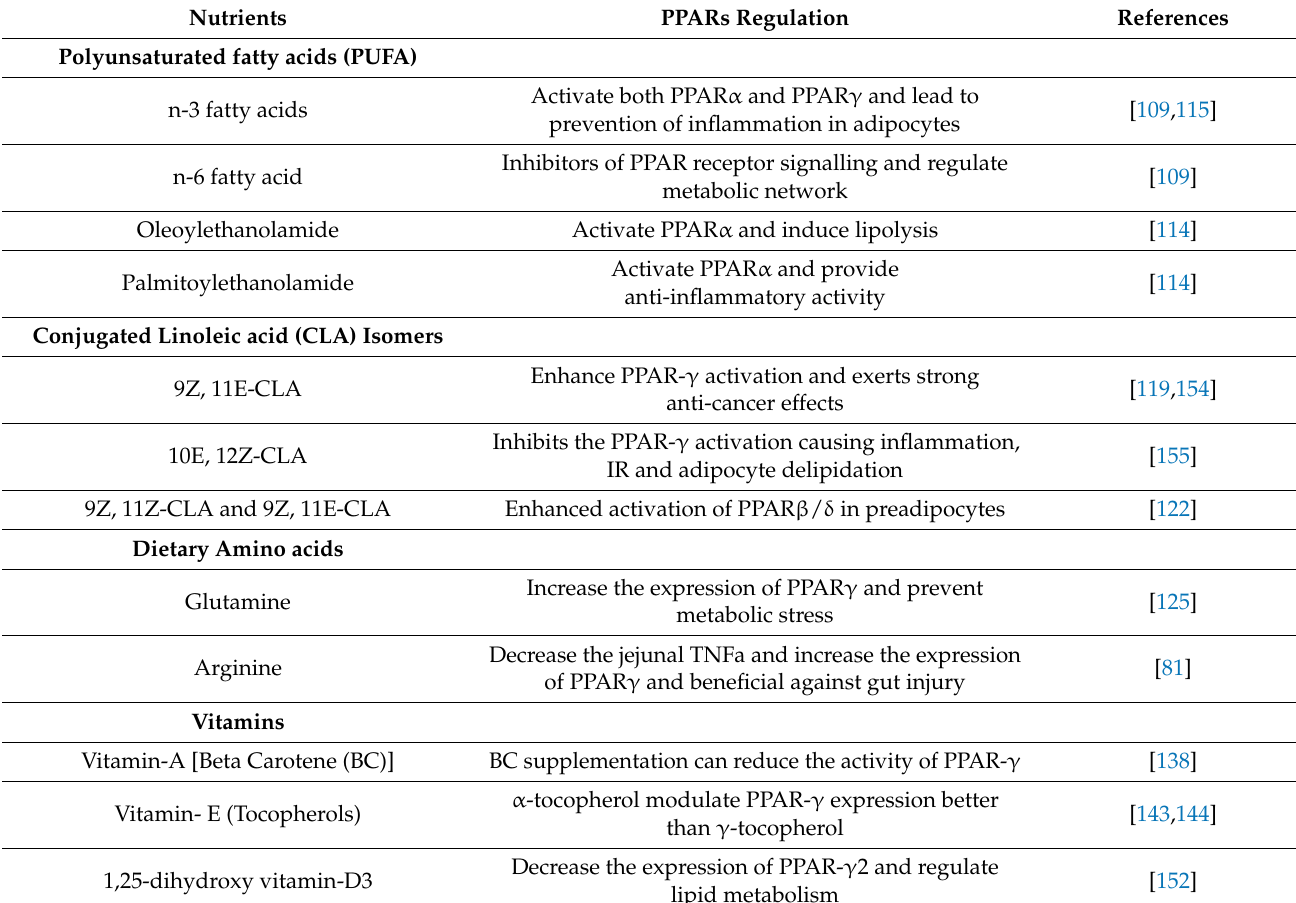
Table 2. Effect of different nutrients on PPARs